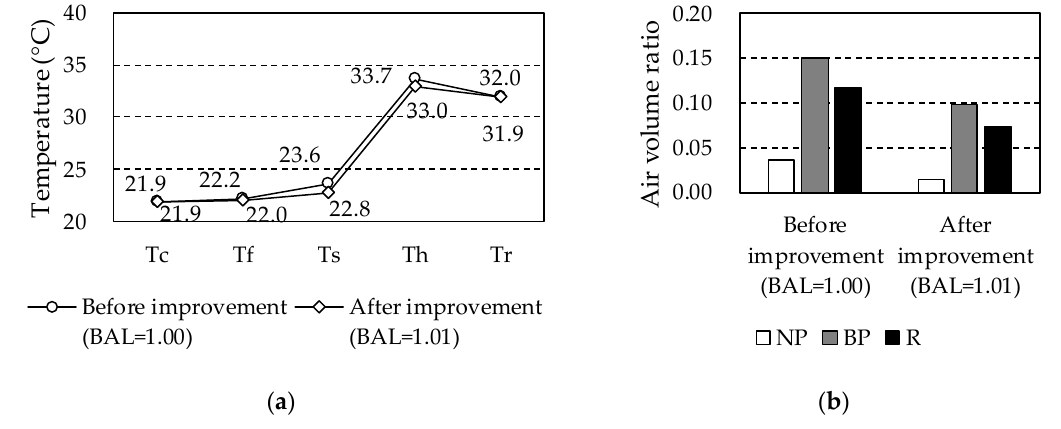
Figure 10. Improvement effect of thermal environment at CRAC fan frequency of 63 Hz: ( a ) average temperature of each part and ( b ) air-management metrics.